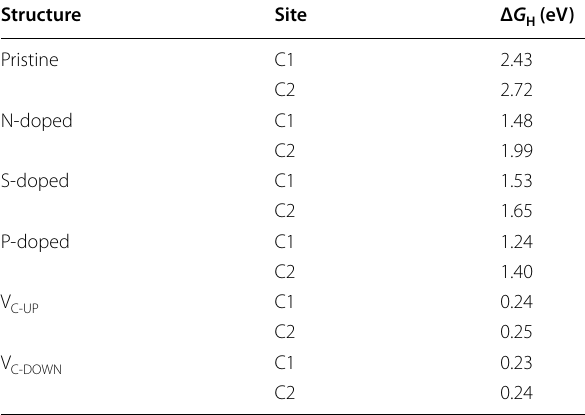
values for different possible active sites H